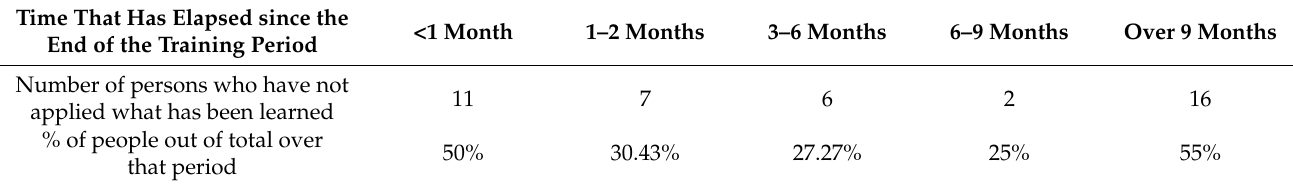
Table 3. Failure to apply lessons learned and time